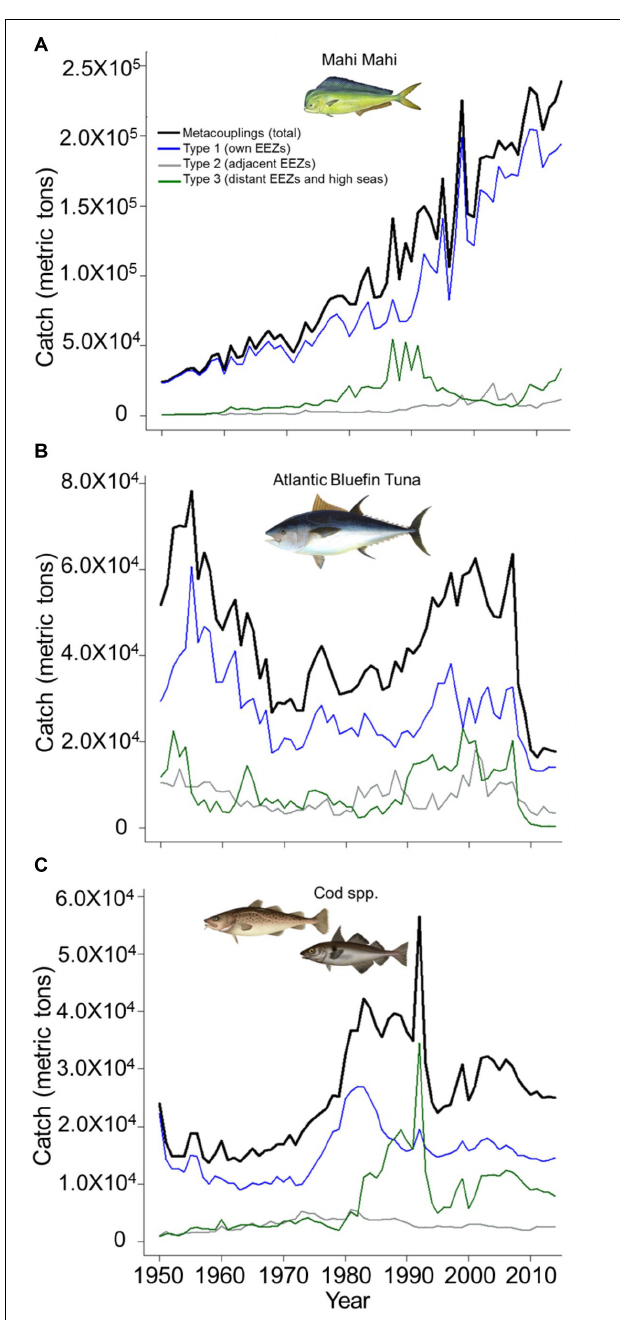
FIGURE 2 | Fisheries catches in 1950–2014 for (A) mahi-mahi, (B) Atlantic bluefin tuna, and (C) cods (family Gadidae). Catch types are metacouplings (total catch in all exclusive economic zones [EEZs] and the high seas), Type 1 (catches by nations in their own EEZs), Type 2 (catches in adjacent EEZs), and Type 3 (catches in distant EEZs and the high